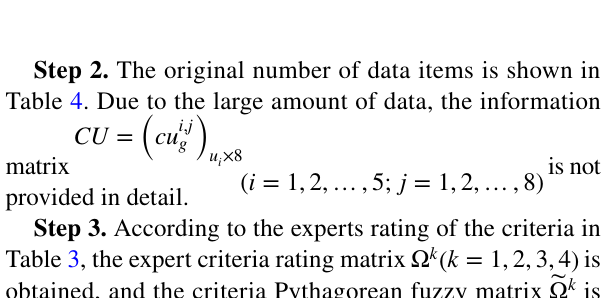
Table 12 The comprehensive rating sc i of alternative vehicle model a i Vehicle